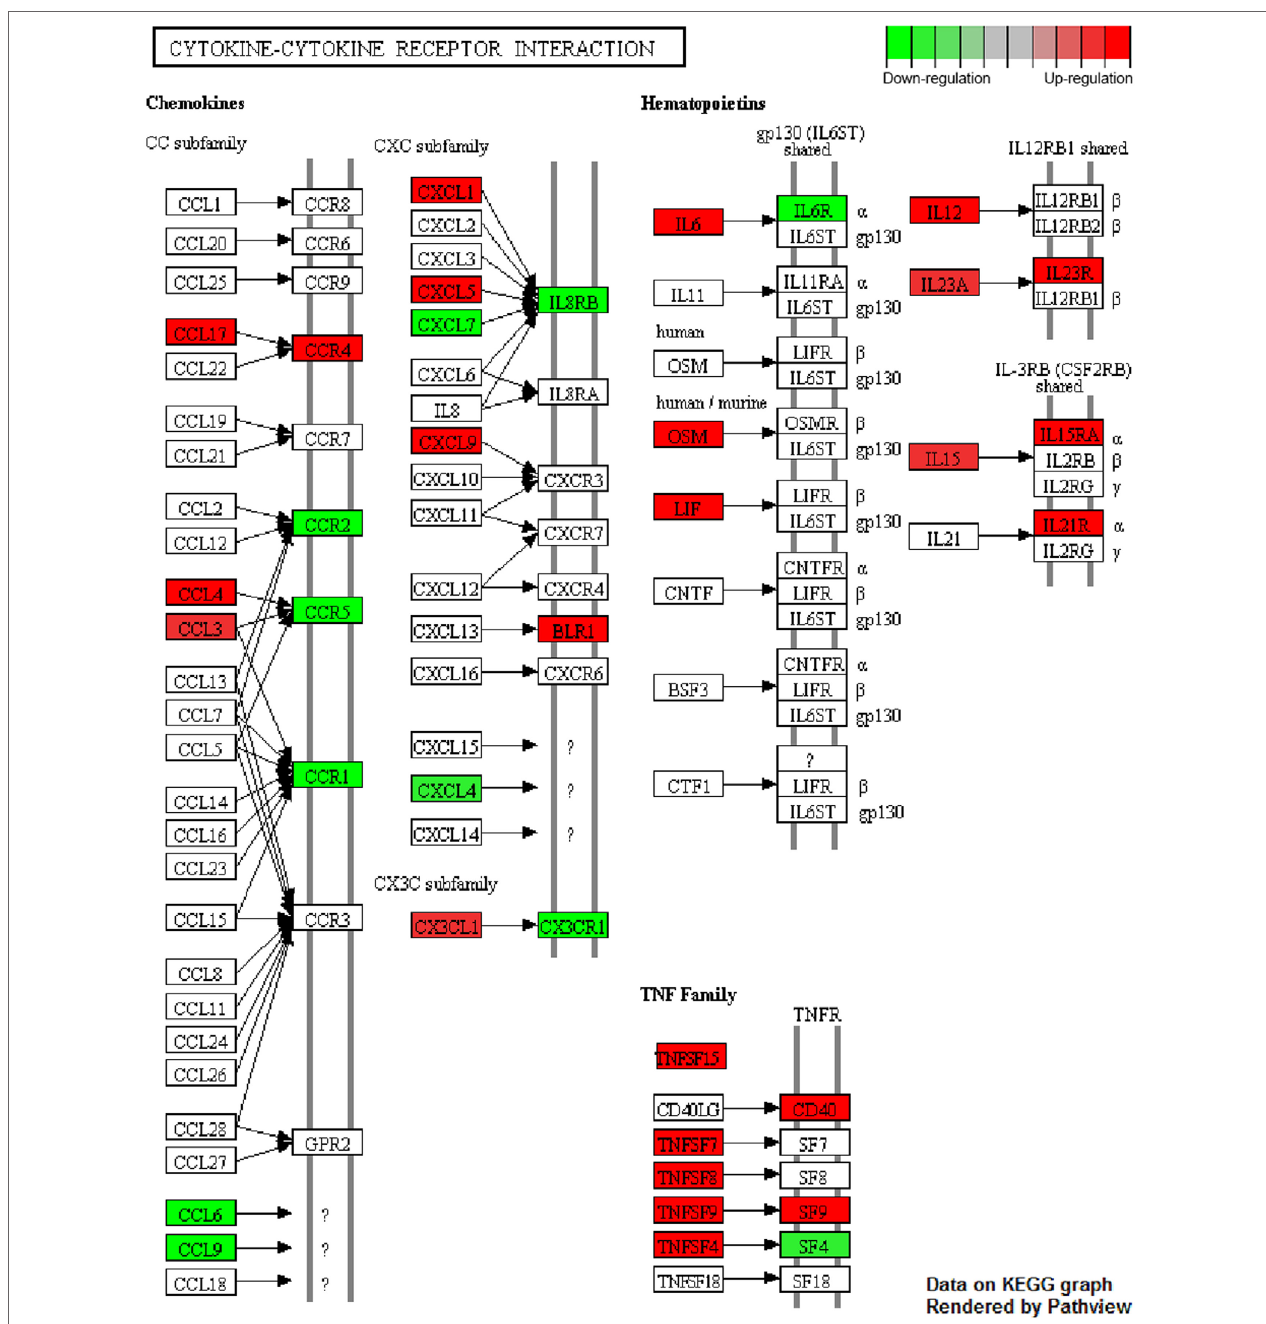
FigUre 9 | Cytokine–cytokine receptor interaction pathway. Genes found to be differentially up- (red) and downregulated (green) in dendritic cells (DCs) stimulated with the mix of PLGA-chCPAp-MPLA, PLGA-chH1p-MPLA, and PLGA-KMP-11p-MPLA nanoformulations (mix B) compared to unstimulated DCs. “Cytokine- cytokine receptor interaction” (mmu04060) KEGG pathway was adapted in order to place emphasis specifically on the deregulated genes ( p < 0.05, 1.5-fold upregulation or downregulation), as dictated by the microarray experiments. Pathview package was utilized to color nodes of differentially expressed